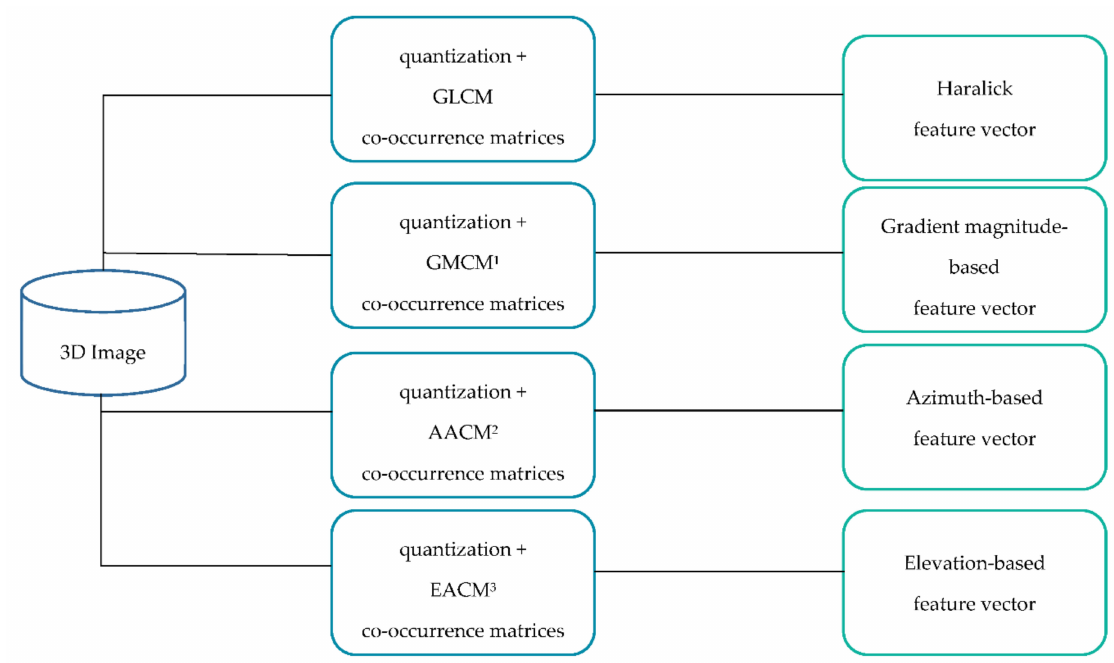
Figure 6. The IGLCM_3D block scheme (© [2020] IEEE. Reprinted [adapted], with permission, from [29]). 1 Gradient Magnitude Co-Occurrence Matrix; 2 Azimuth Angle Co-Occurrence Matrix; 3 Elevation Angle Co-Occurrence